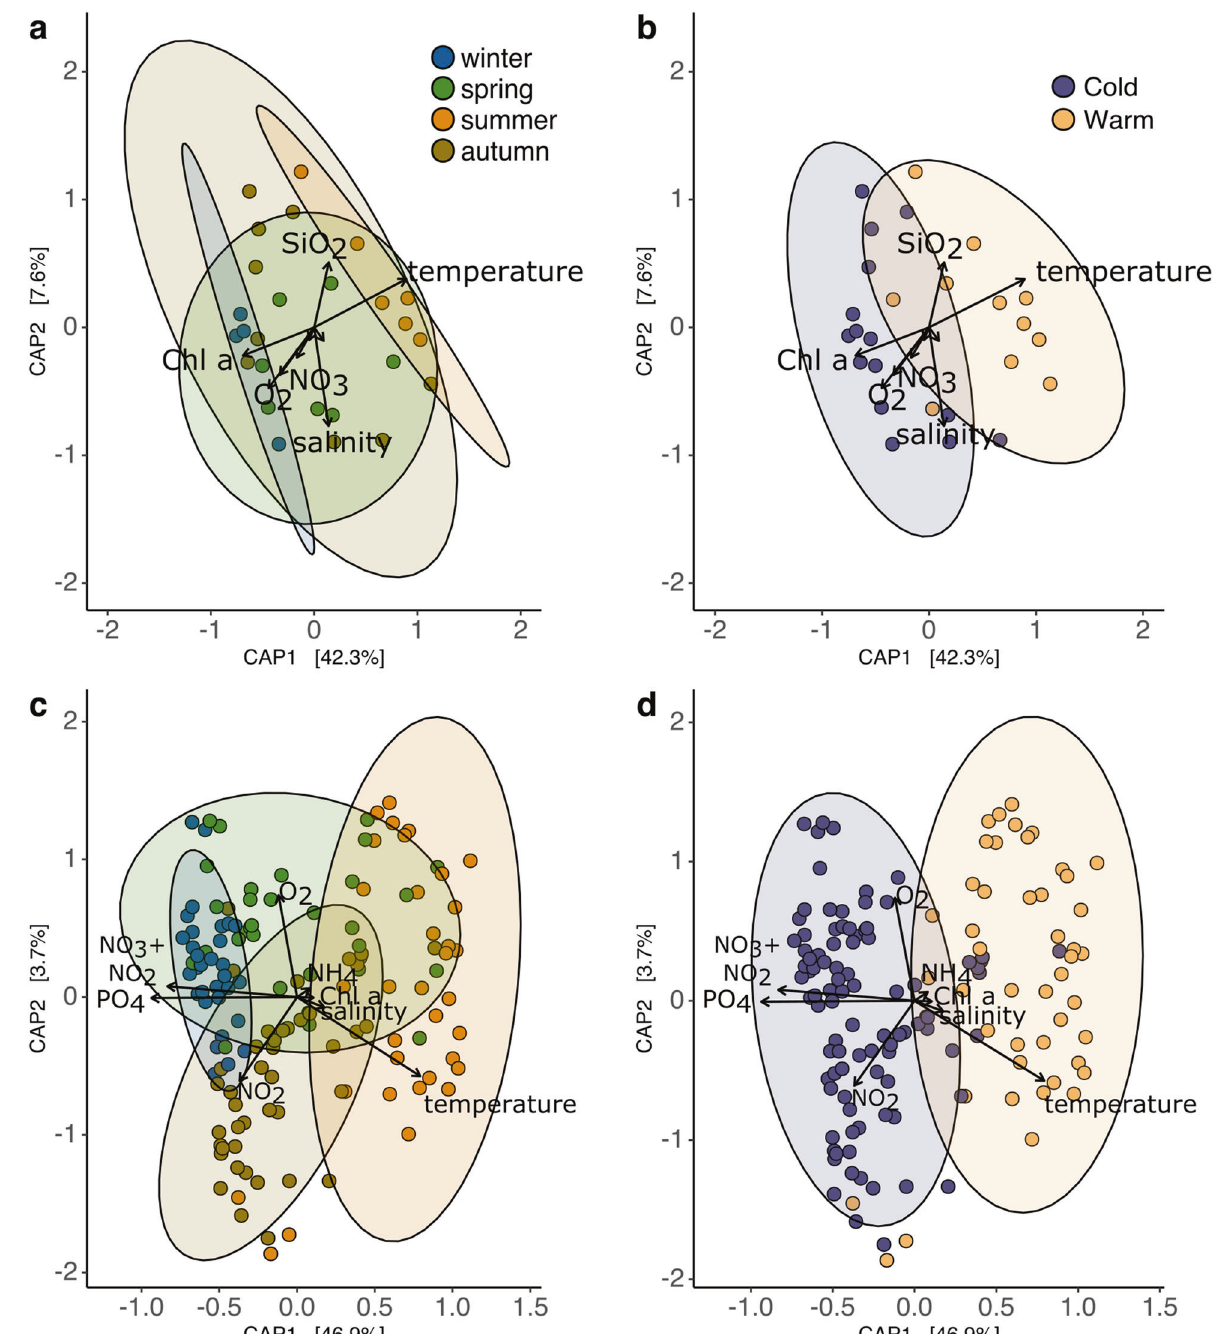
Fig. 4 Canonical Analysis of Principle Coordinates (CAP) of SAR11 ASV pro fi les constrained by physical and chemical environmental parameters. Ordinations were generated with the Bray – Curtis dissimilarities between samples. Bray – Curtis dissimilarities were estimated using rare fi ed ASV counts. Axis x and y represent the fi rst and second constrained components, respectively. The percentages between brackets are the fraction of the variance explained by each component under the linear model of the explanatory variables. Overlaid arrows represent the explanatory variables, the arrow ’ s length is proportional to the variation explained and its orientation shows the direction in which the variable increases. a BATS monthly samples from 2016 to 2018 color-coded by season. b BATS monthly samples from 2016 to 2018 color-coded by cold (22 September – 1st May) and warm clusters (2nd May – 21 September). c WEC weekly samples color-coded by season ( d ) WEC weekly samples color-coded by cold and warm clusters (as in b 16 weeks. In-phase oscillations decoupled after the vernal equinox variable in both years, however, the changes in 2016 clearly of 2017 (Fig. S11). display similar progressions to those of the SAR11 Bray – Curtis Signi fi cantly different environmental variables between the dissimilarities (Fig. 6b). Wavelet coherence analysis corroborated uncoupled and coupled phases (Table S2) were maximum that from the vernal equinox of 2016, Euclidean and Bray – Curtis and weekly average wind speed and river fl ow measurements distances were in phase with a signi fi cant oscillation period of